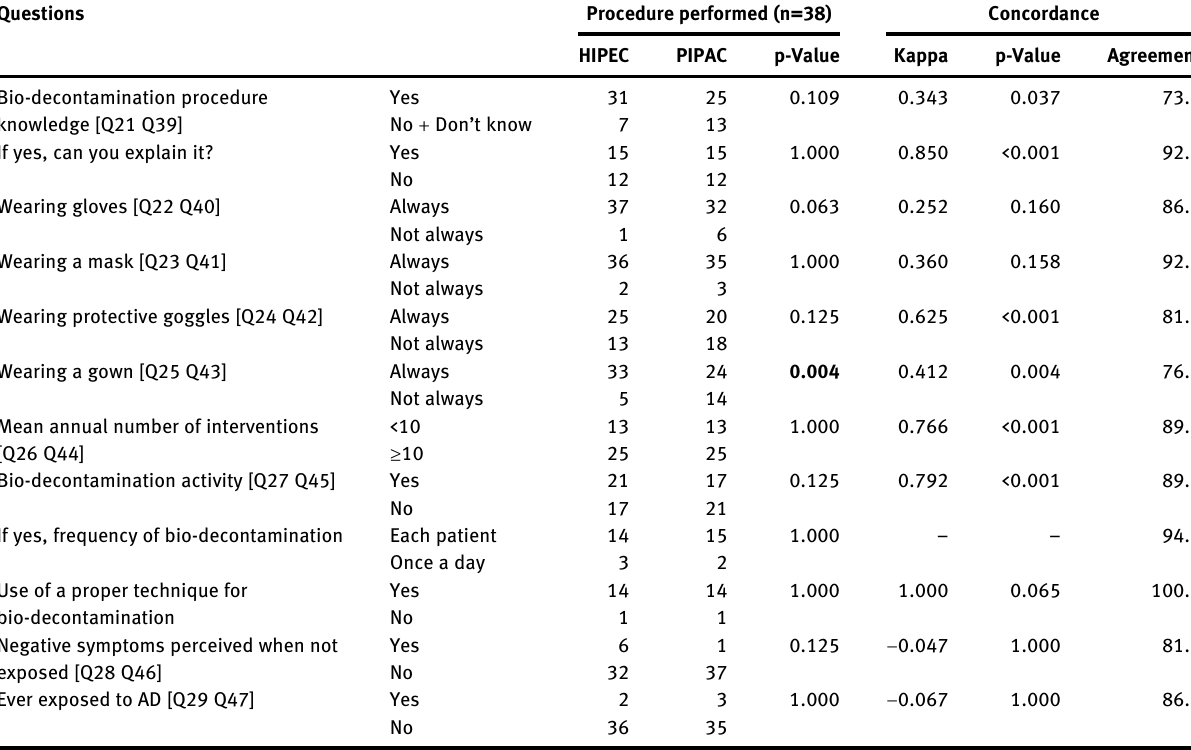
Table  A: Practice questions. Questions